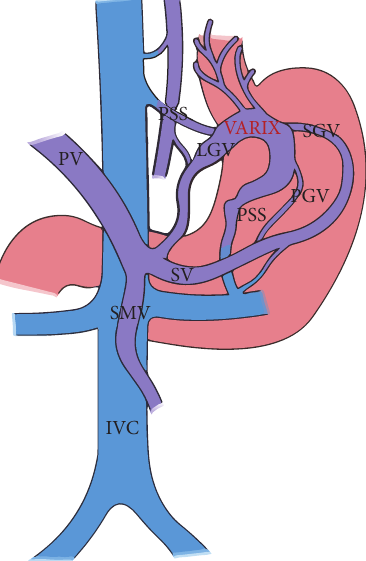
Figure 3: The basic portosystemic venous anatomy of gastric varices. PV: portal vein, SV: splenic vein, SMV: superior mesenteric vein, IVC: inferior vena cava, PSS: portosystemic shunt, SGV: short gastric vein, LGV: left gastric vein, and PGV: posterior gastric vein. Modified from